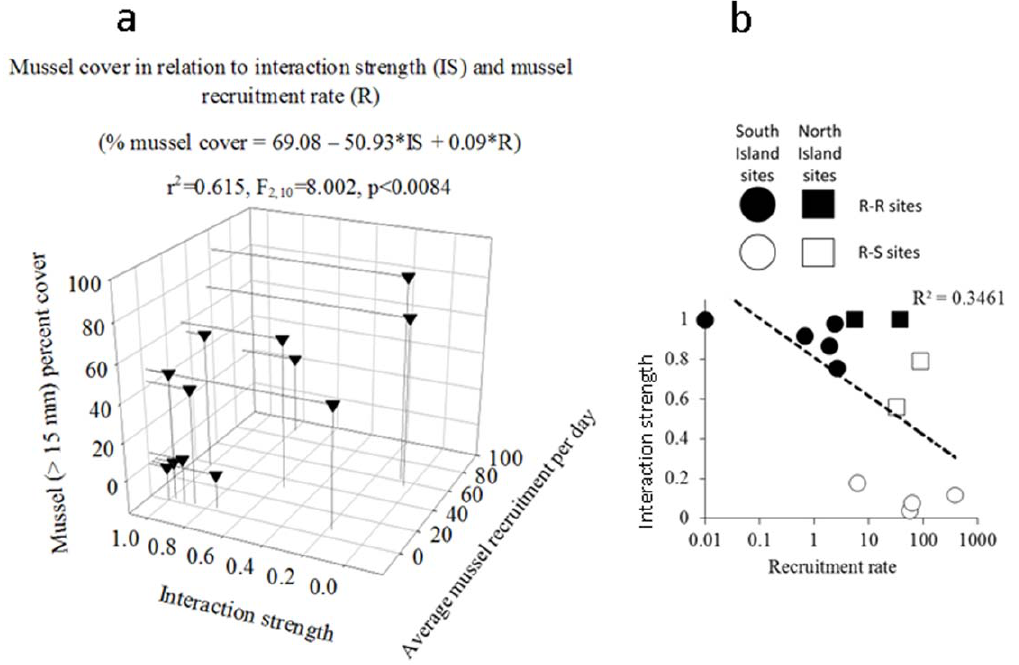
Figure 4. The relationship among recruitment rate, interaction strength and mussel percent cover on the rocks (a) and between recruitment rates (on a log scale) and interaction strength (b). For b, black symbols are R-R sites, blank symbols are R-S sites, circular symbols are South Island east coast sites, triangular symbols are South Island west coast sites, and square symbols are North Island east coast sites. Daily recruitment rates are calculated for August–December 2004 for the North Island and the east coast of the South Island sites, and October 2004– February 2005 for the South Island west coast sites.